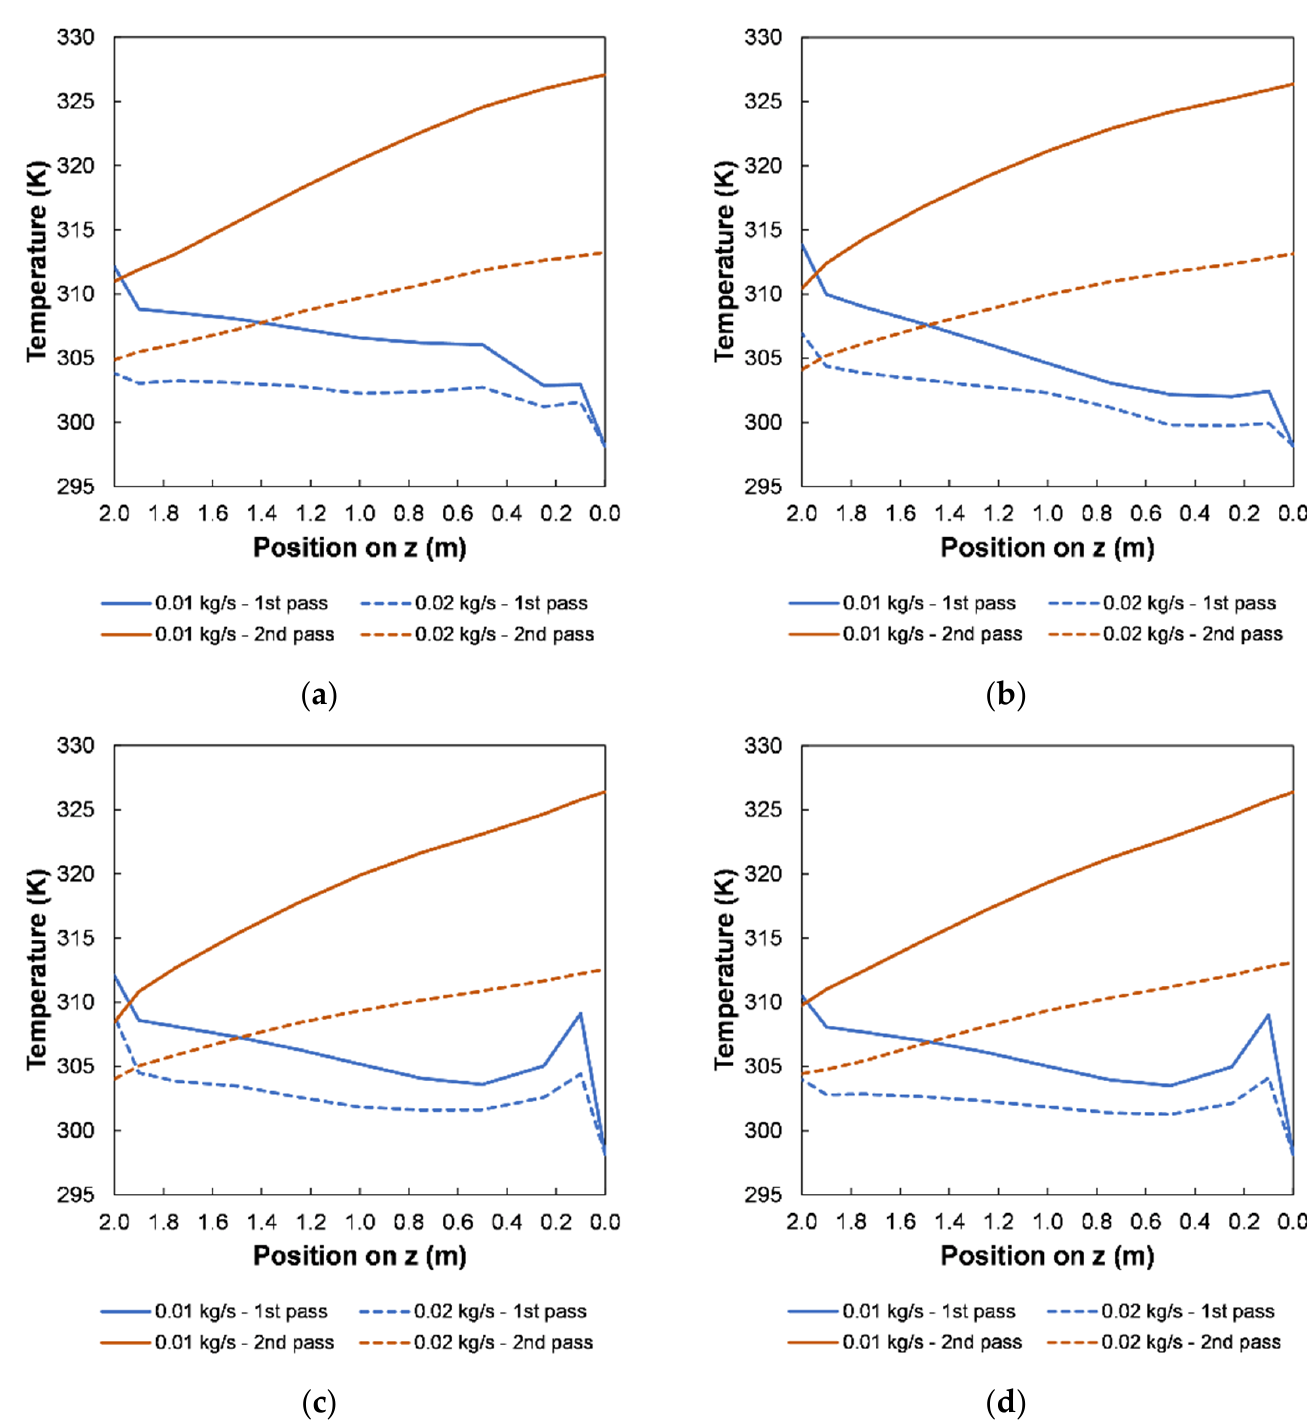
Figure 10. Air temperature profiles. ( a ) Down–Down; ( b ) Down–Up; ( c ) Up–Up; ( d ) Up–Down. In the first pass for the configurations with the inlet from the bottom, (a) Down–Down and (b) Down–Up, the temperature profile has a slight increase near the entrance (z = 0.1